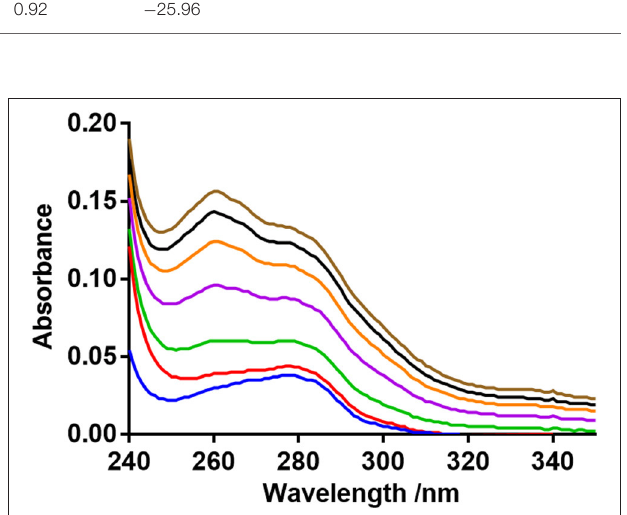
FIGURE 6 | BSA UV-absorption spectra in presence of